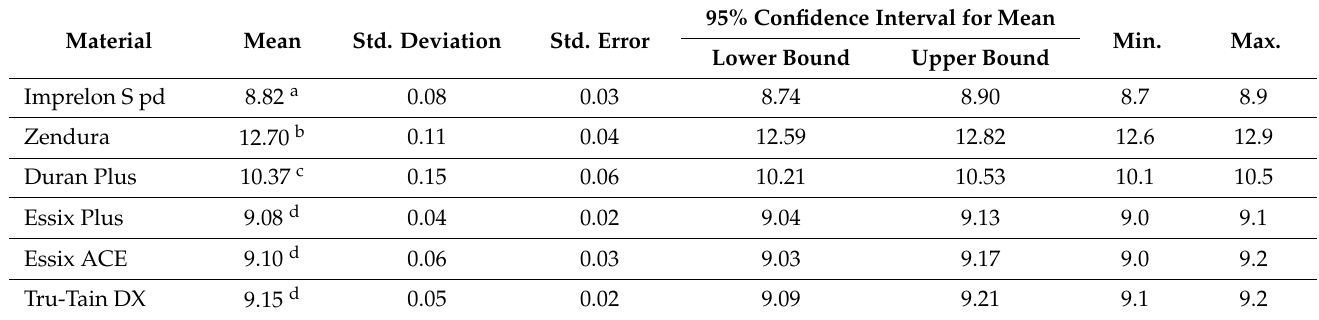
Table 3. Descriptive analysis of hardness values of Group 1 (the same small letter indicates no significant difference between materials at p < 0.05 level).